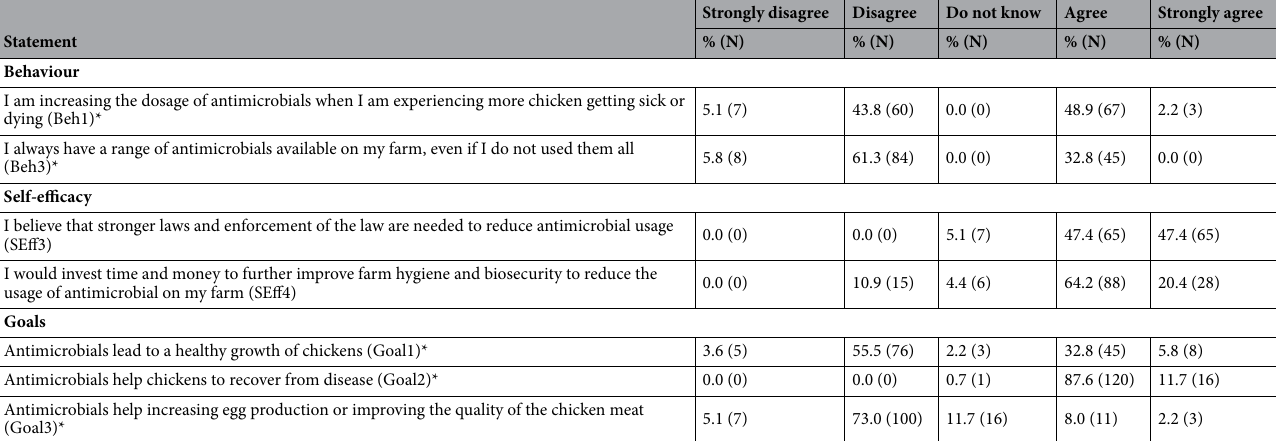
Table 1. Percentage (N) of responses to statements (‘observed variables’) provided by commercial layer and broiler chicken farmers in Chattogram, Bangladesh. Abbreviations in brackets (Beh, SEff and Goal)